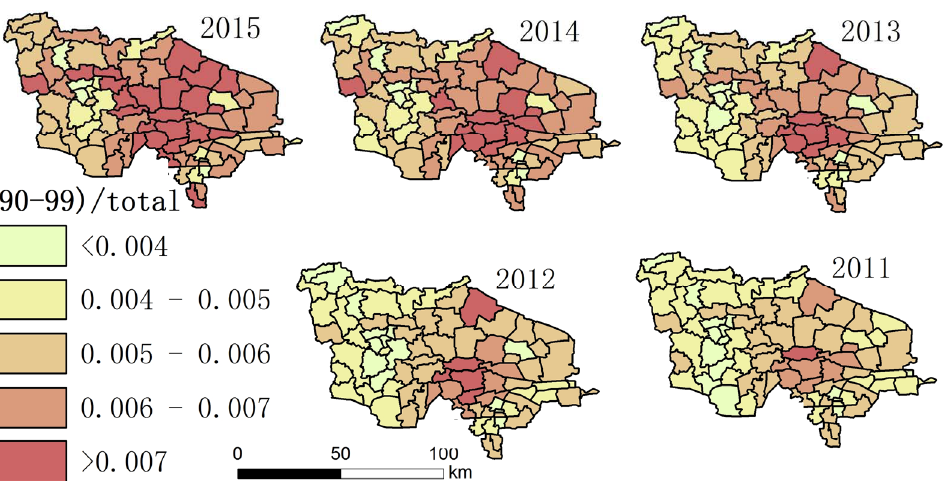
Figure 3. The proportion of the total population aged 90–99 in each